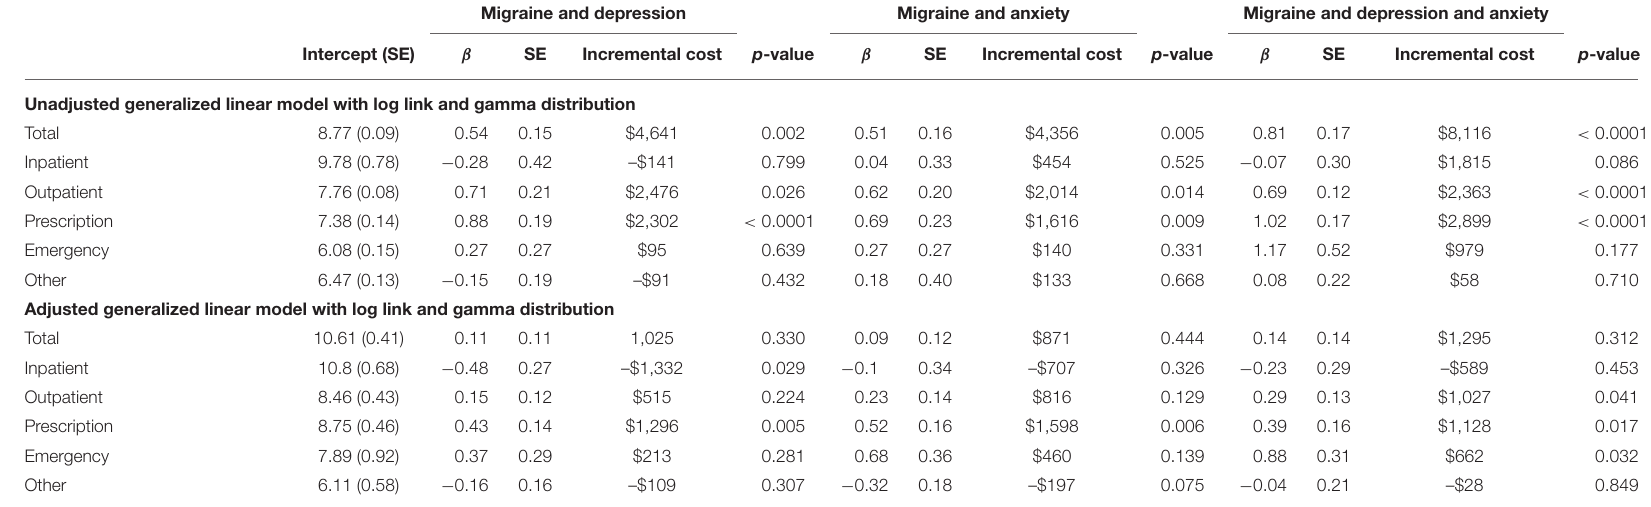
TABLE 3 | Intercept and parameter estimates for the migraine groups from generalized linear models with log link and gamma distribution on healthcare expenditures among adults with migraine (Medical Expenditure Panel Survey 2012, 2014, and 2016). Migraine and depression Migraine and anxiety Migraine and depression and anxiety Intercept (SE) SE Incremental cost Incremental